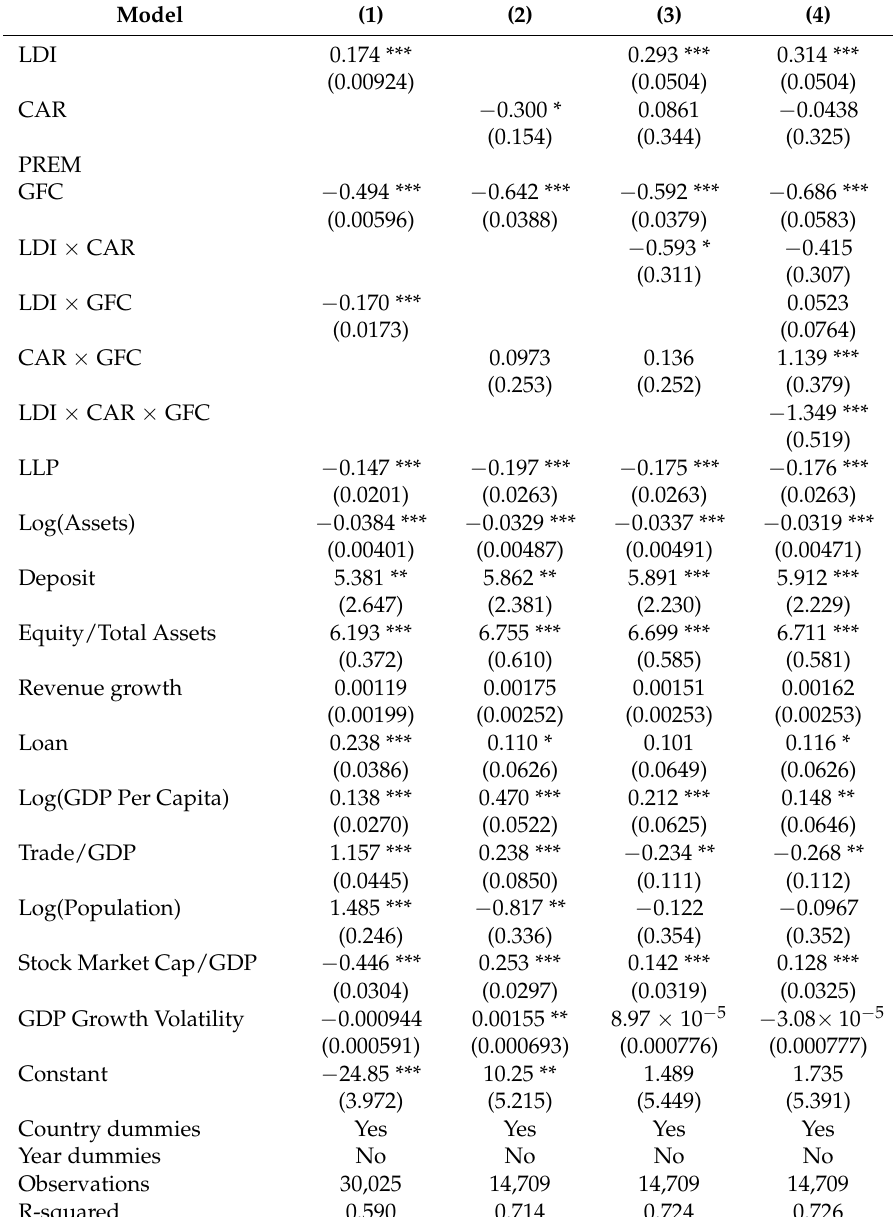
Table 3. Effect of deposit insurance and capital adequacy on bank